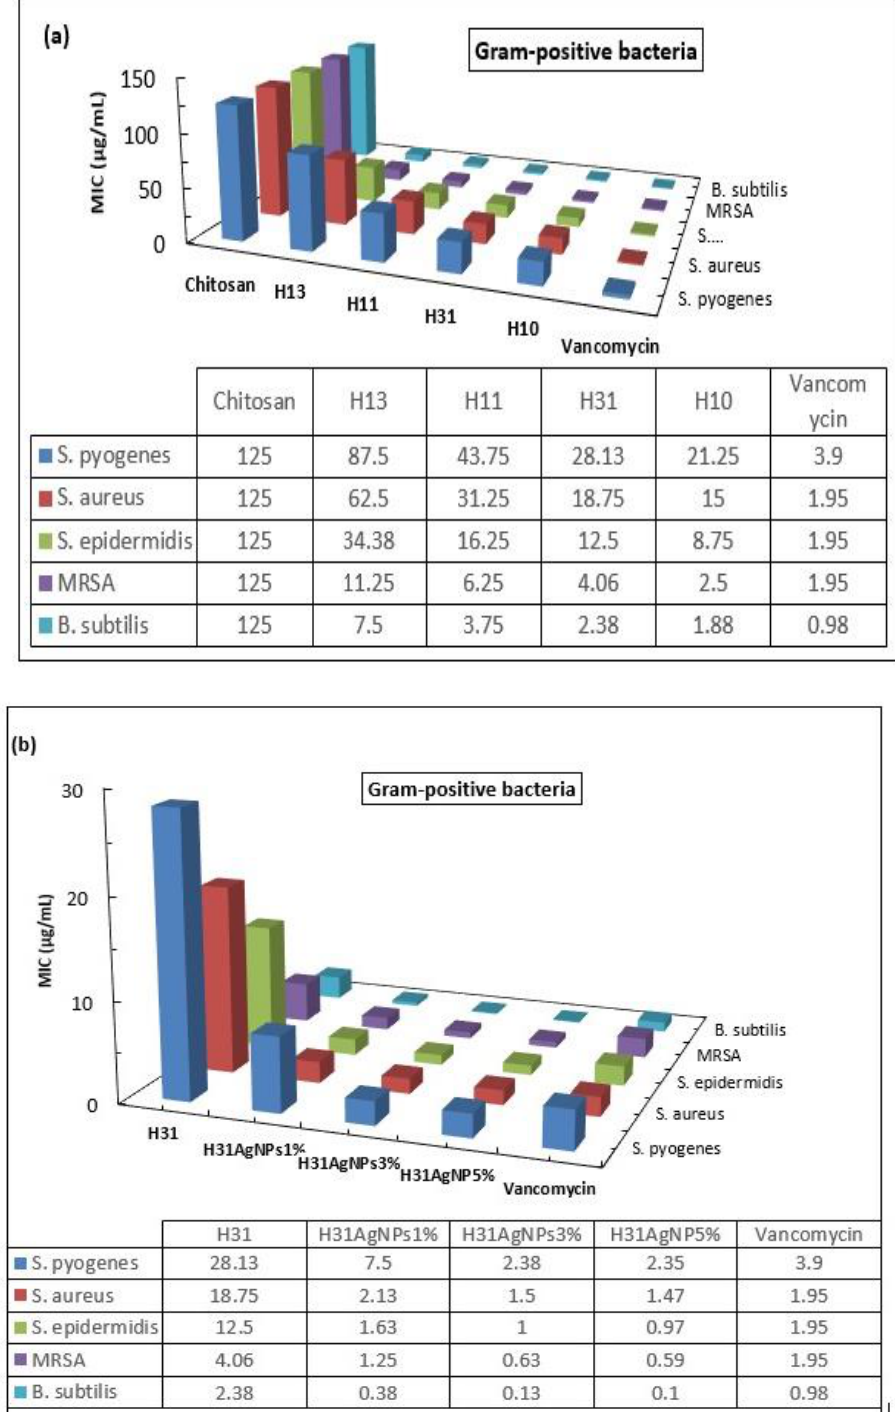
Figure 10. MIC values of: ( a ) hydrogels and ( b ) AgNP composites against the tested Gram-positive bacteria.